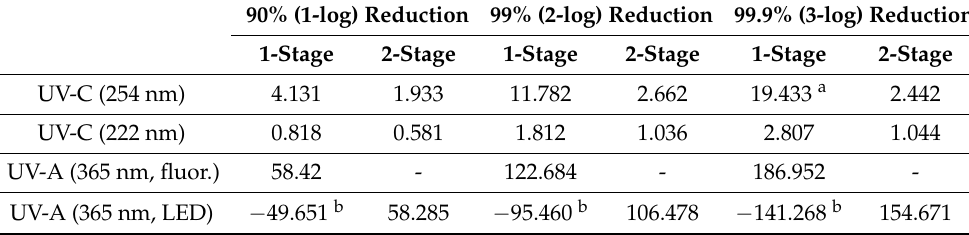
Table 3. Estimated the UV dose (mJ/cm 2 ) needed for target % aerosolized PRRSV reduction in fast-moving air, using both one-stage and two-stage inactivation